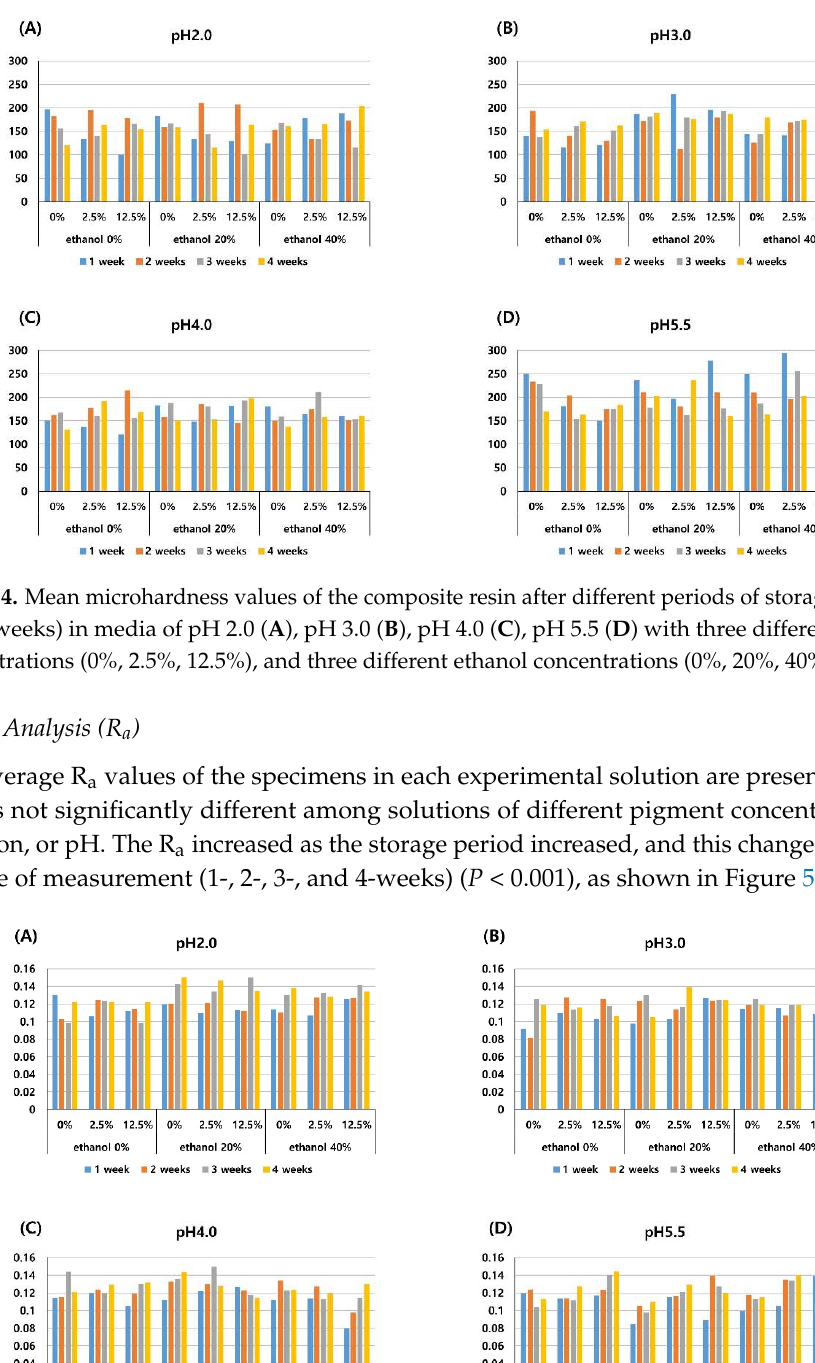
Figure 3. Mean translucency parameters of the composite resin after different periods of storage (1 ‐ , 2 ‐ , 3 ‐ , and 4 ‐ weeks) in media of pH 2.0 ( A ), pH 3.0 ( B ), pH 4.0 ( C ), pH 5.5 ( D ) with three different pigment concentrations (0%, 2.5%, 12.5%), and three different ethanol concentrations (0%, 20%, 40%).